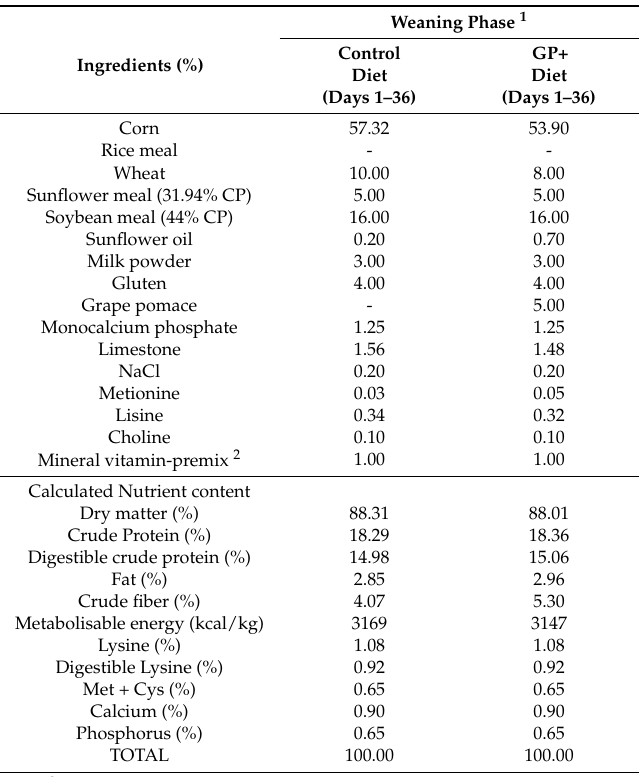
Table 1. Compound feed and calculated nutrient content of experimental diets